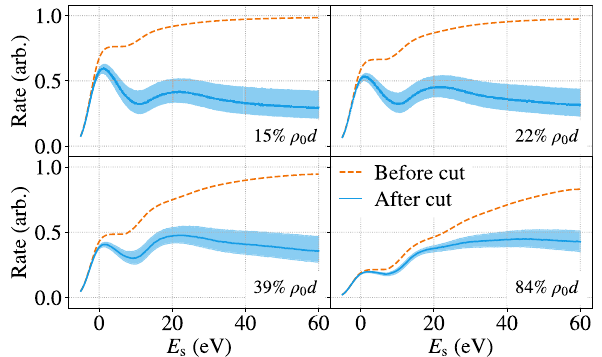
Fig. 9 Differential ( (cid:15) dif n ( E s ) ) and integral ( (cid:15) int n ( E s ) ) scattering func- tions for up to four-fold